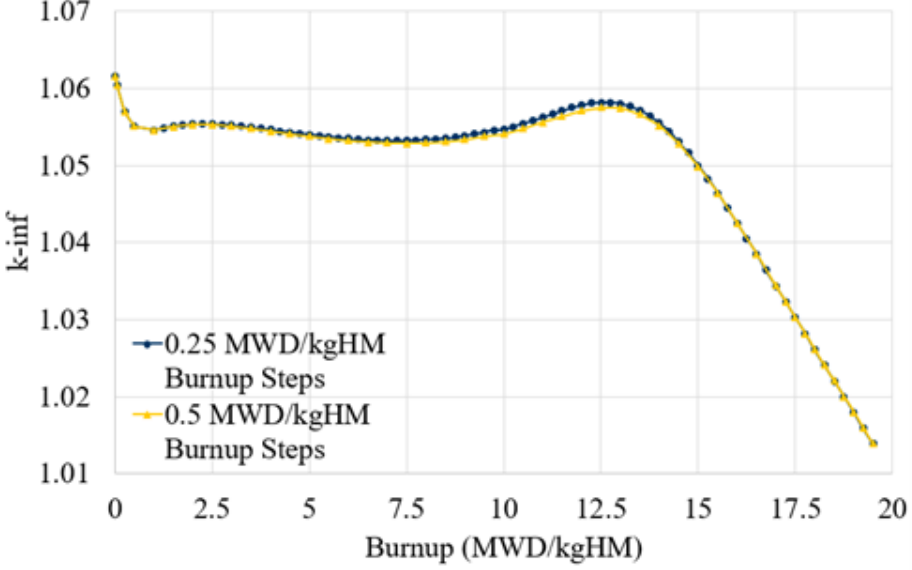
Figure 25. k inf calculated using burnup intervals of 0.5 MWD/kgHM and 0.25